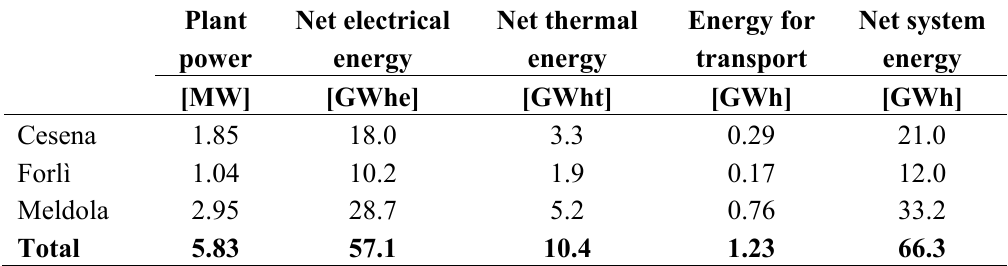
Table 6. Results of the optimal use of biomass in cooperative plants (yearly values).